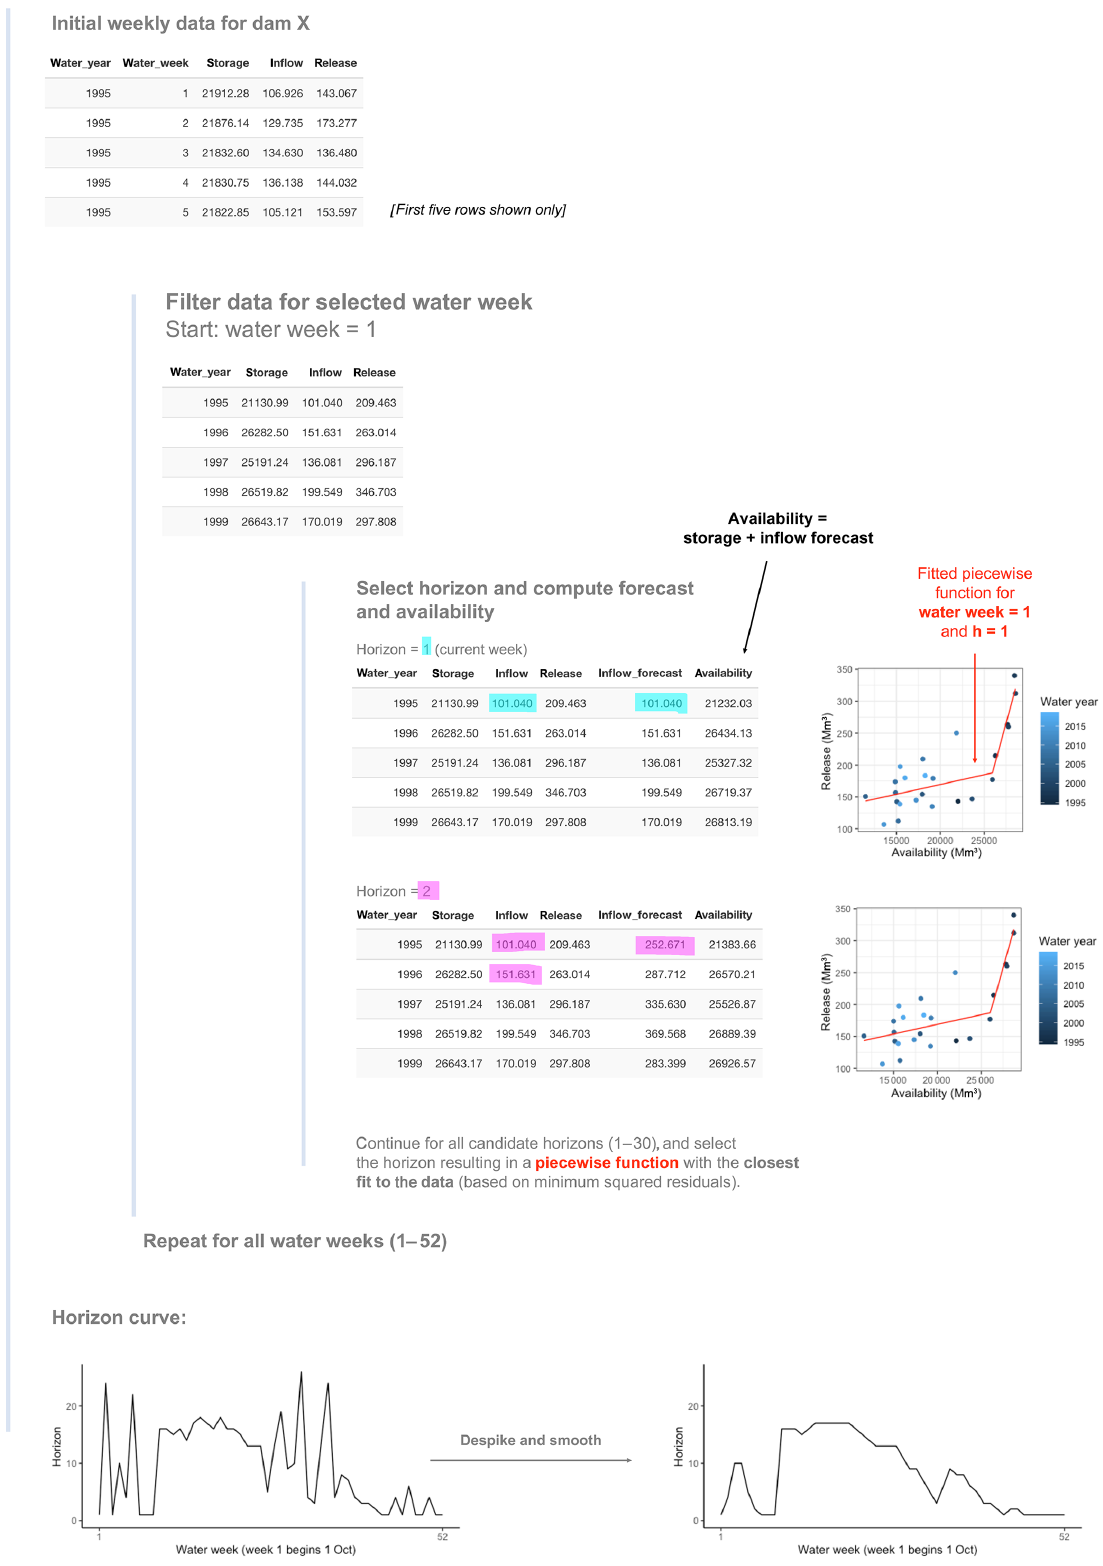
Figure 1. Example of the derivation of the horizon curve for a given dam using piecewise linear functions fitted to release ( r ) availability ( a ) scatters. Best-fit horizons (based on coefficient of determination) for each water week (i.e., each row of the release–availability plots above) are combined to create the